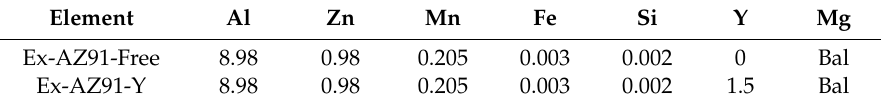
Table 1. Chemical composition of Ex-AZ91-free and Ex-AZ91-Y Mg alloy (%). Element Al Zn Mn Fe Si Y Mg Ex-AZ91-Free 8.98 0.98 0.205 0.003 0.002 0 Bal Ex-AZ91-Y 8.98 0.98 0.205 0.003 0.002 1.5